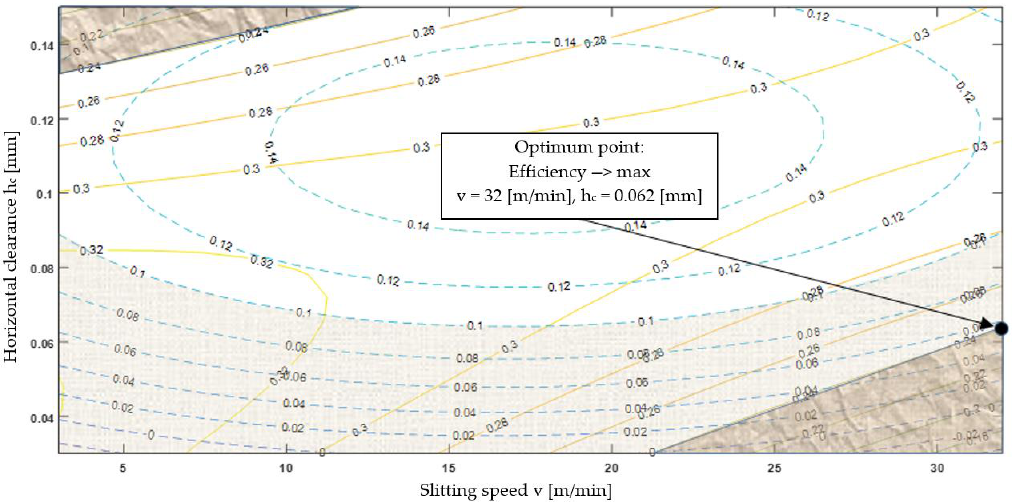
Figure 16. Graphical optimization of the cutting process.